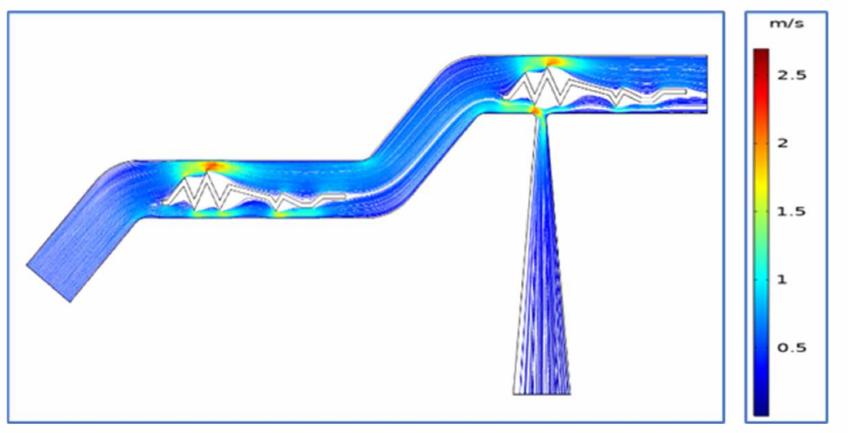
Figure 11. Velocity streamlines in dragonfly wing